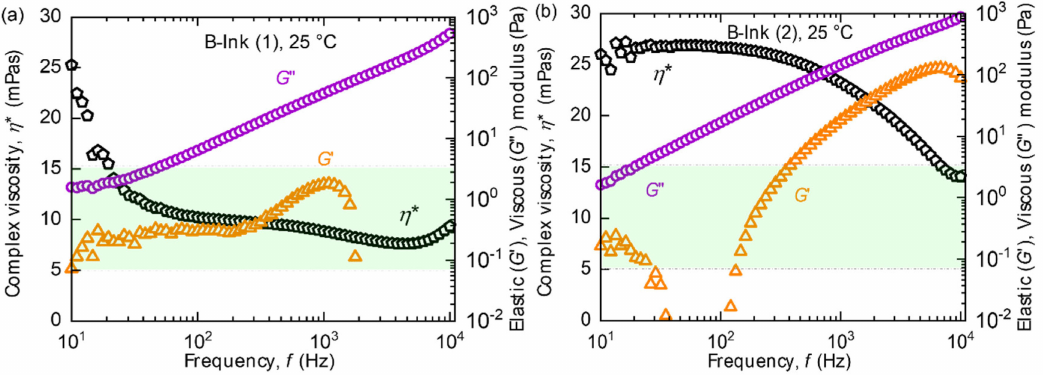
Figure 8. The complex viscosity ( η * ), elastic ( G (cid:48) ) and viscous ( G ”) modulus measurement of ( a ) B-ink (1), and ( b ) B-ink (2) with respect to frequency (f) utilizing the PAV rheometer. Rectangular boxes in light green shade represent the range of rheological properties as recommended by supplier, for inkjet